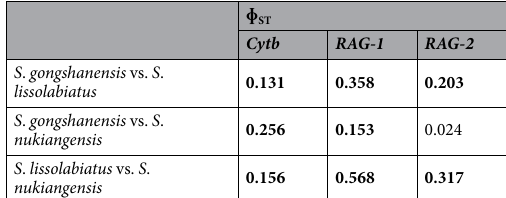
ɸ ST Cytb RAG-1